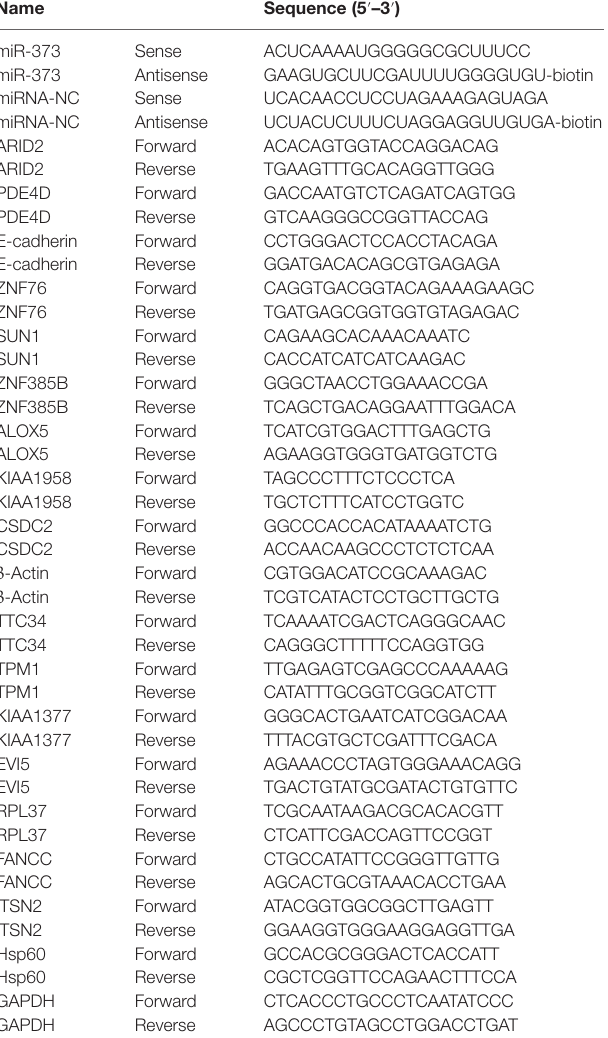
TABLE 1 | miRNA sequences and real-time quantitative PCR